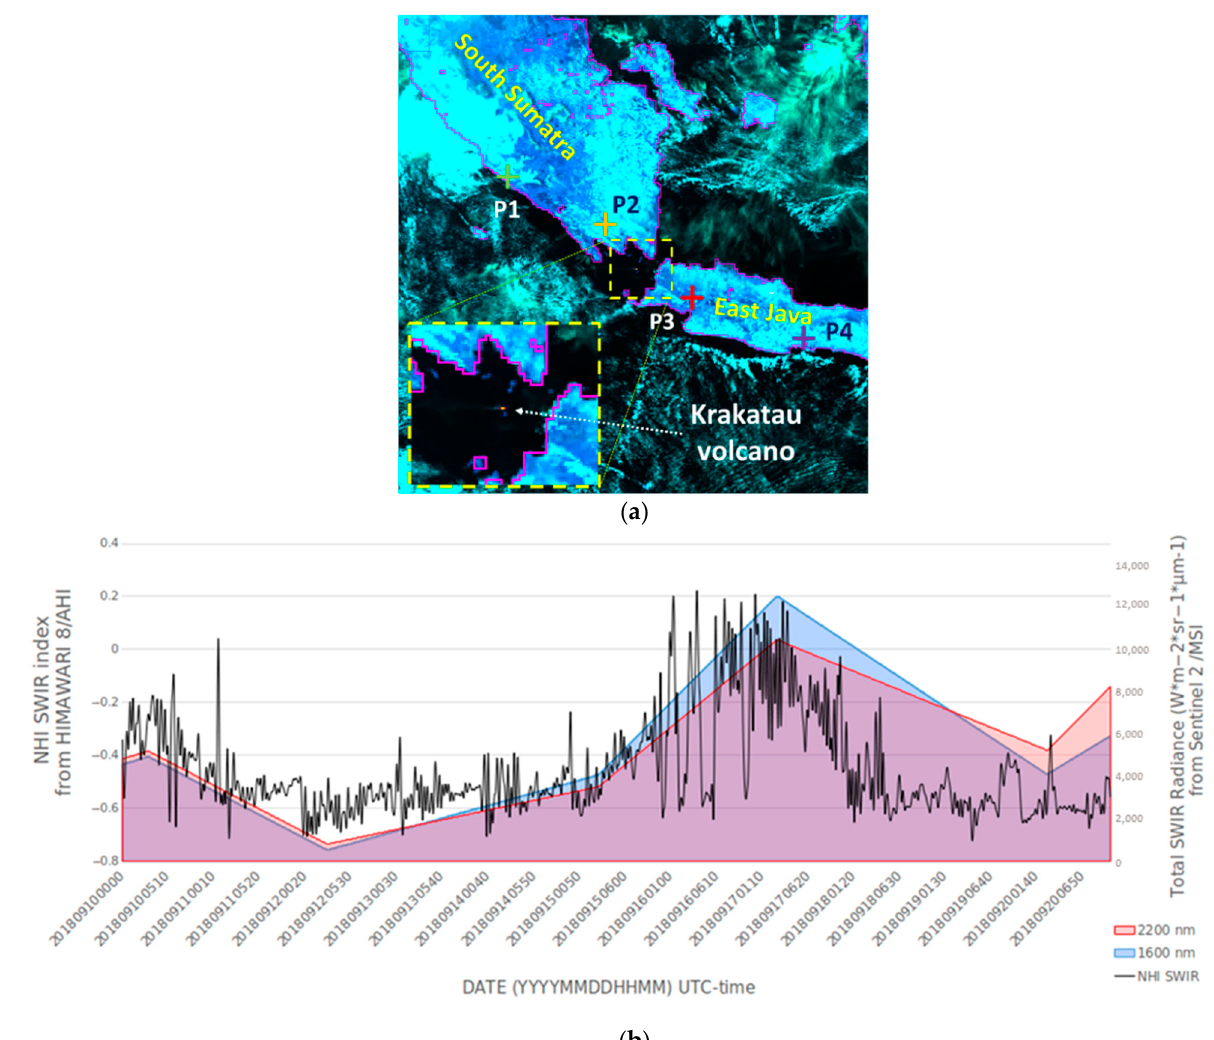
Figure 5. ( a ) RGB (Red = B7; Green = B6; Blue = B5) image from Himawari-8 AHI data of 17 September 2018 at 10:00 LT showing the Krakatau volcano and two hot pixels (see red and yellow ones); ( b ) Time series of the NHI SWIR index computed, from daytime Himawari-8 AHI data of 10 − 20 September 2018, over the pixel including the Krakatau crater area (top panel), and curves of the total SWIR1 and SWIR2 radiance from S2-MSI data retrieved using the NHI tool.